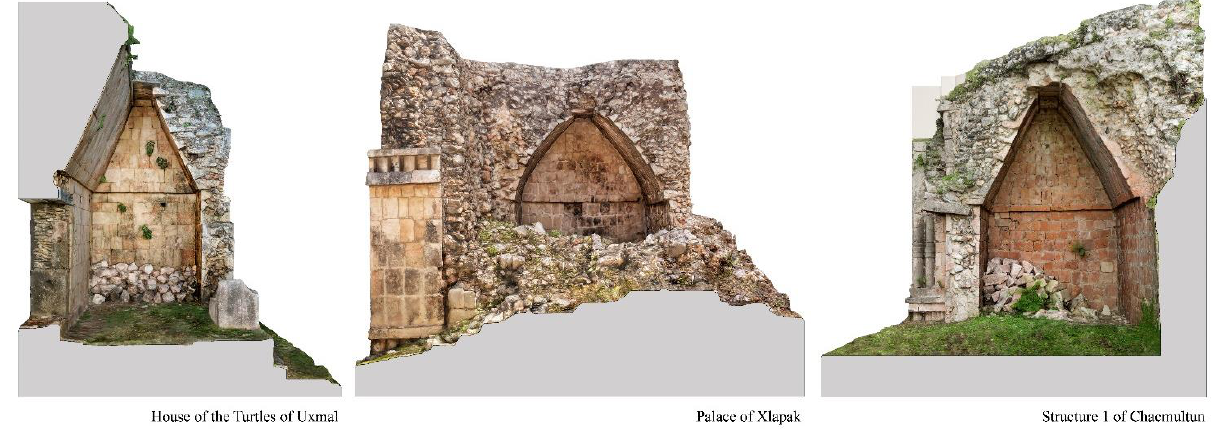
Figure 5. 3D models of three Puuc vaults obtained from the photogrammetric